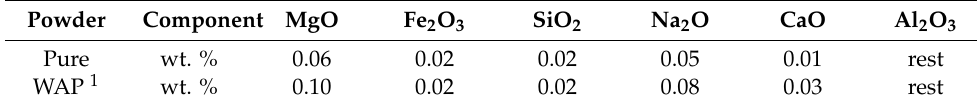
Table 1. Chemical composition of pure and waste alumina